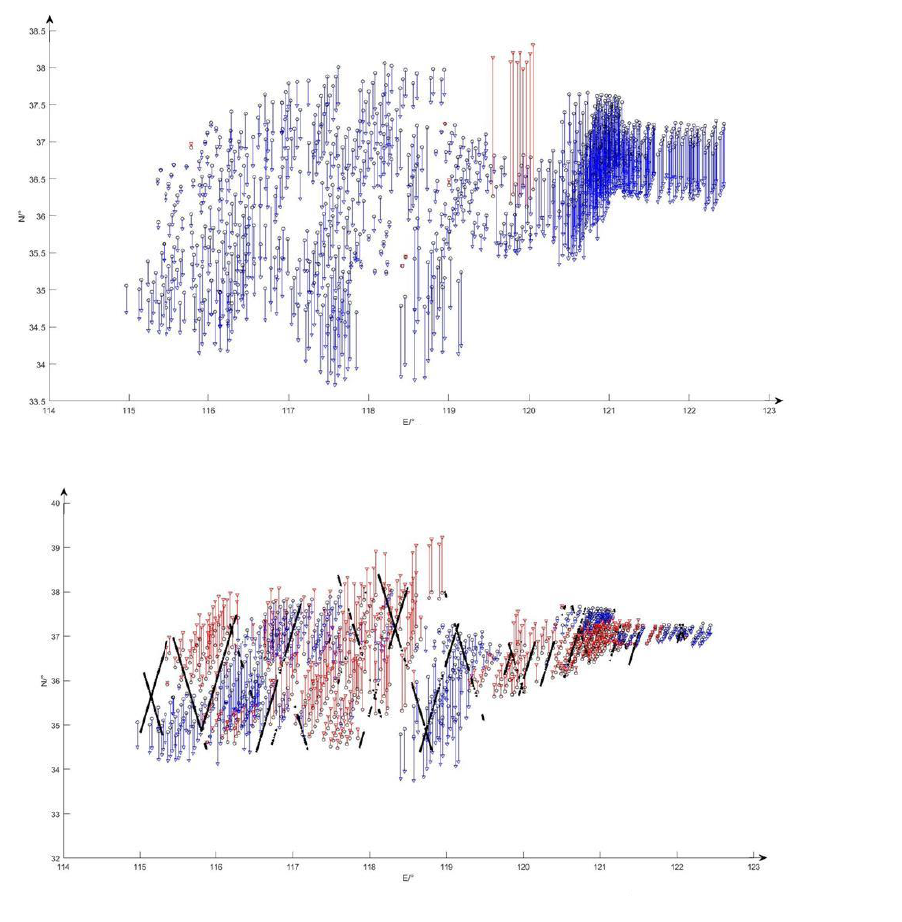
Figure 5. Distribution of elevation residual before and after the introduction of laser point in the experimental area In Figure 5, the circle indicates the checkpoint, the point indicates the laser point, and the arrow indicates the checkpoint elevation residual value. The upper graph of Figure 5 shows the distribution of the residual height of the free network adjustment. The lower graph shows the regional network adjustment height can after the introduction of laser